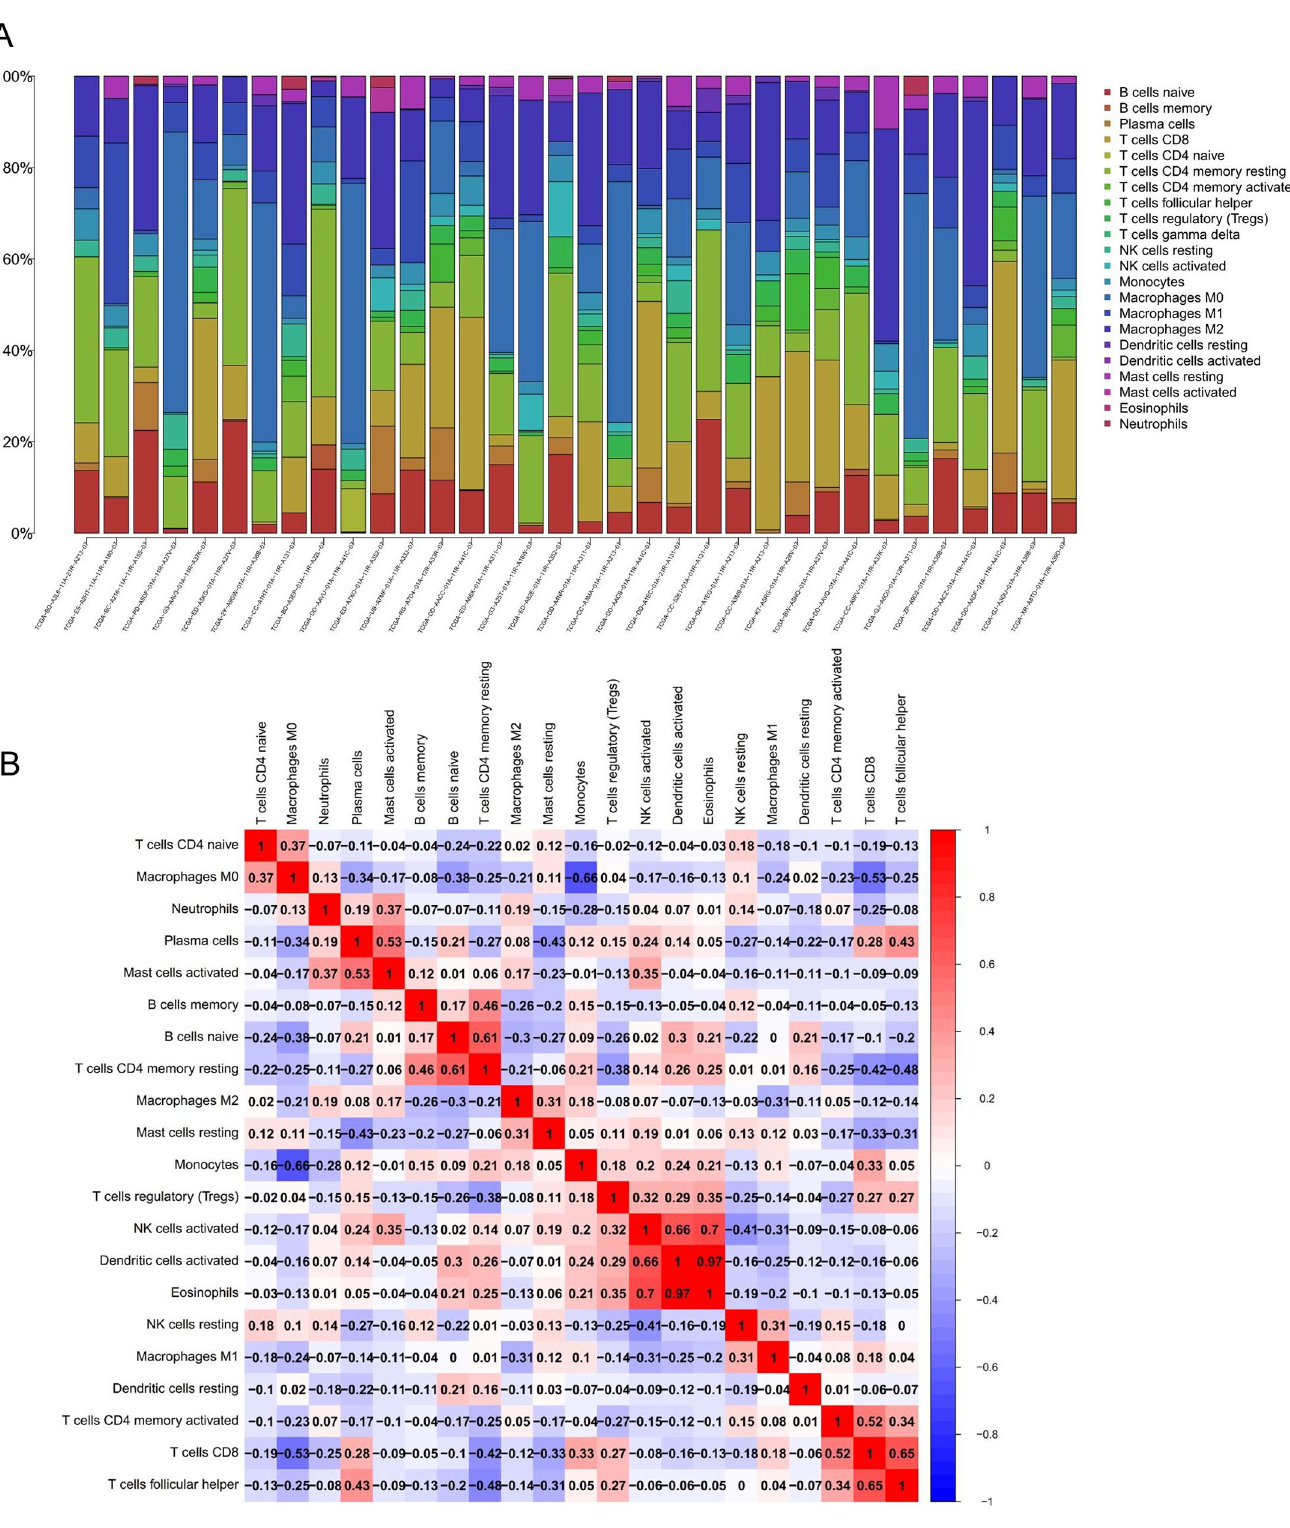
PLOS ONE | https://doi.org/10.1371/journal.pone.0254829 July 29,